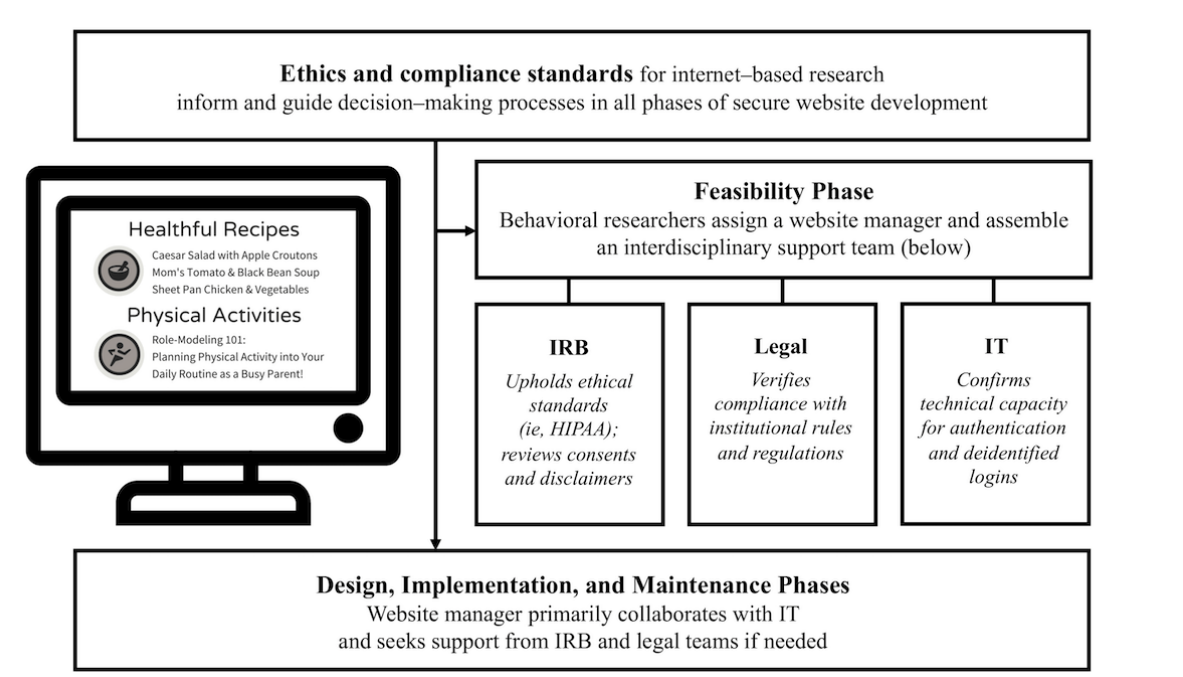
Figure 1. Workflow representing interdisciplinary collaboration required for secure website development in a university research setting. IRB: Institutional Review Board; IT: information